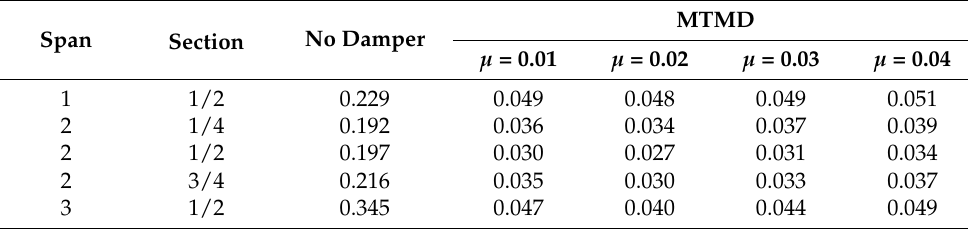
Table 6. Effect of the mass ratio on the lateral acceleration of the bridge under load case 5.